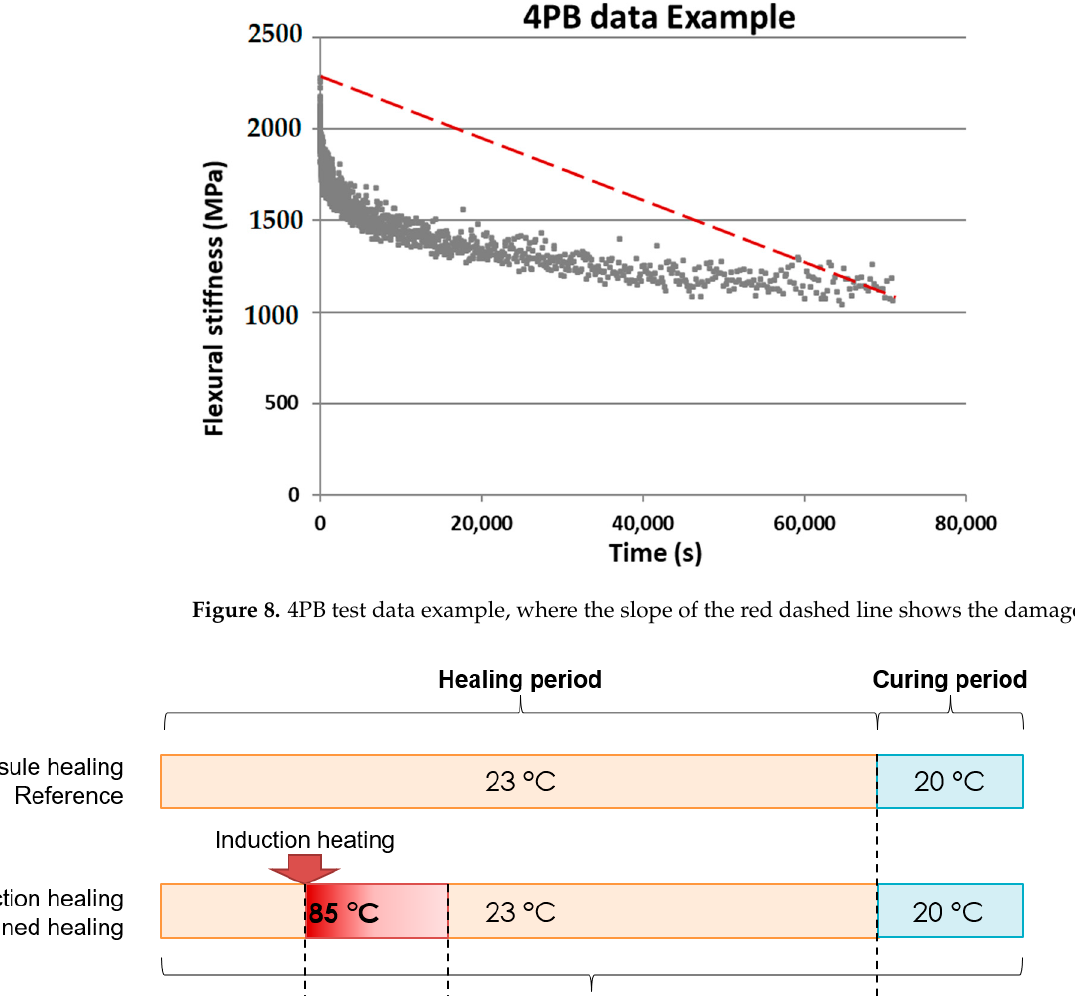
Figure 8. 4PB test data example, where the slope of the red dashed line shows the damage rate.